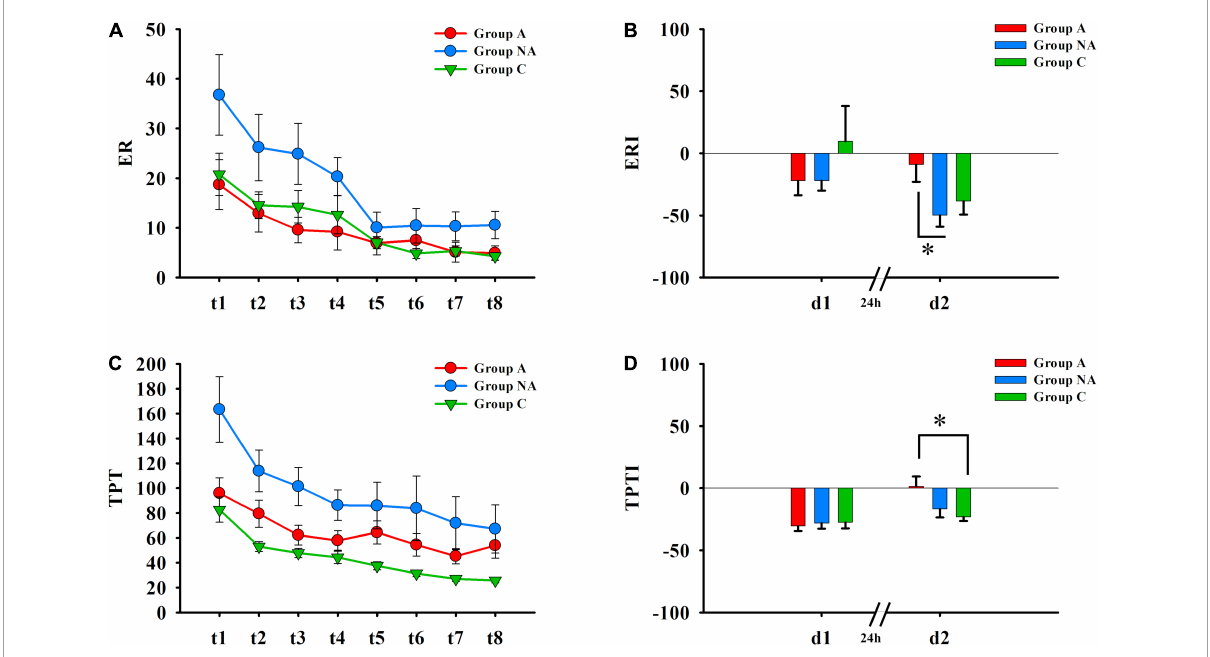
FIGURE2 Procedural memory. (A) Error rates (ER) recorded during the eight trials (Day 1: t1–t4; Day 2: t5–t8) of the MTT. (B) Differences in ERI of day 1 (d1) and of day 2 (d2) among A, NA, and C groups (Kruskal–Wallis test, Bonferroni correction. ∗ P = 0.043). (C) Time per trial (TPT) registered during the eight trials (Day 1: t1–t4; Day 2: t5–t8) of the MTT. (D) Differences in TPTI of day 1 (d1) and of day 2 (d2) among A, NA, and C groups (Kruskal–Wallis test, Bonferroni correction. ∗ P =